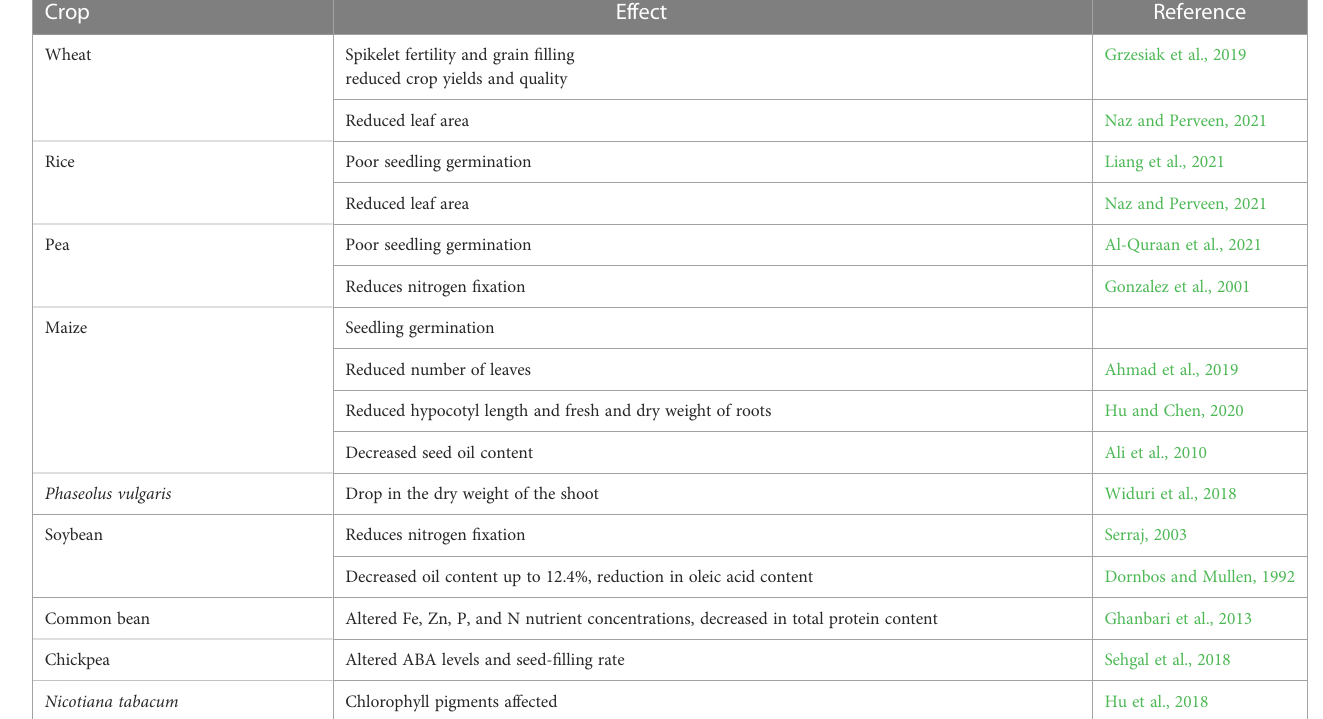
TABLE 2 Impacts of drought stress on some major crops.